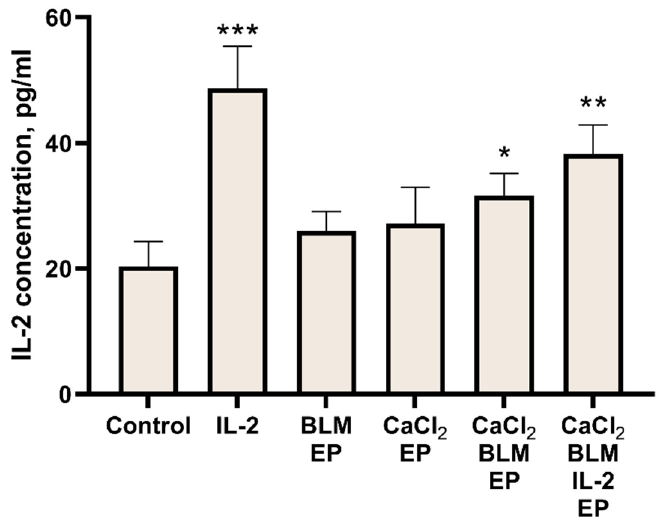
Figure 10. IL-2 concentration changes in serum 10 days after tumor treatment using IL-2 coding plasmid electrotransfer, bleomycin electrotransfer and calcium electroporation, or a combination of all. Mice bearing two tumors were used in all experimental groups, except IL-2 group. For muscle transfection, IL-2 coding plasmid solution (1 mg/mL) was injected into both tibialis anterior muscles and electroporated 10 min later using eight 200 V/cm, 20 ms duration pulses. Eight 1500 V/cm, 100 µs duration pulses were used for the tumor electroporation. Bleomycin solution (200 µL, 470 µM) was injected i.v. while CaCl 2 solution (half of the tumor volume, 168 mM) was injected i.t. Serum was collected at day 11. Statistical significance of differences between experimental groups and con- trol were evaluated using t-test. *, **, and *** symbols represent statistical significance of p < 0.05, p < 0.01, and p < 0.001, respectively, between corresponding experimental groups and control. 4. Discussion In our recent study, we demonstrated the negative bystander effect on CHO cells after bleomycin electrotransfer and hypothesized that the negative bystander effect could be triggered by a similar mechanism to the bystander effect induced by ionizing irradia- tion [37,43,44]. In this study, we extended analysis of the bystander effect and for the first time showed the presence of bystander effect on 4T1 cells after calcium electroporation (Figure 2). The bystander effect disappeared when CM was diluted with growth medium. However, when diluted CM from calcium electroporated cells was mixed with diluted CM from cells treated with bleomycin, the negative bystander effect was restored (Figure 3). Combination of the bystander effect in vitro induced by bleomycin electrotransfer and calcium electroporation suggested a possibility of a combination of these effects in vivo. We also hypothesized that in in vivo settings, the bystander effect can operate not only on neighboring cells but also modulate the immune response and induce an abscopal effect as suggested by other studies [45,46]. Indeed, we have observed the abscopal effect of combined bleomycin electrotransfer and calcium electroporation treatment both at 1200 and 1500 V/cm pulse application (Figure 6). These results also showed that the abscopal effect induced by bleomycin electrotransfer was stronger than that induced by calcium electroporation, since the latter was absent when 1200 V/cm pulses were used. The mechanism of action of the abscopal effect is closely related to the immune sys- tem of the treated organism [45]. Since IL-2 is known to increase sensitivity and prolifer- ation of natural killer (NK) cells and cytotoxic T cells [47], we decided to monitor changes of this cytokine concentration in serum following abscopal effect inducing electro- poration-based treatments. Additional reason for selecting IL-2 cytokine was the existing literature on its effect in electroporation-based treatments [48–50].